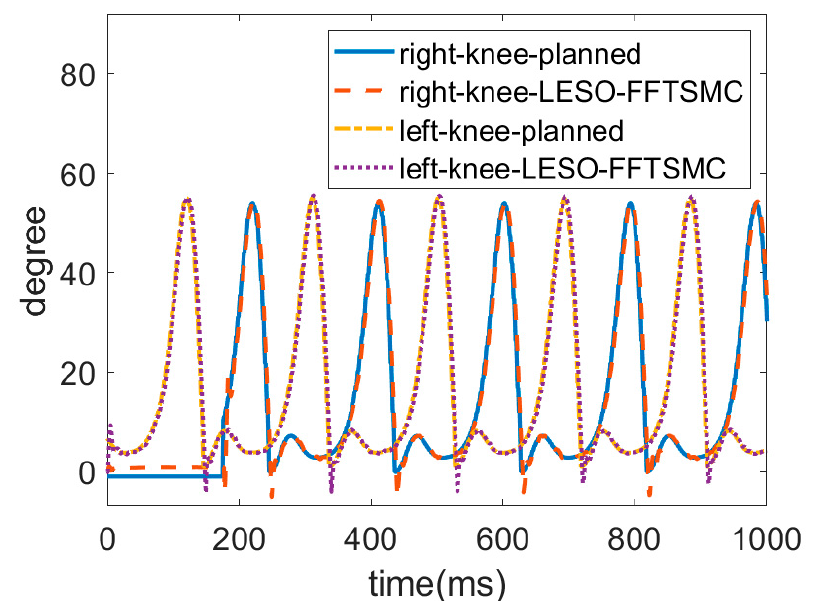
Figure 11. Trajectories of hip joint by LESO-based FFTSMC at walking speed = 0.15 m/s.